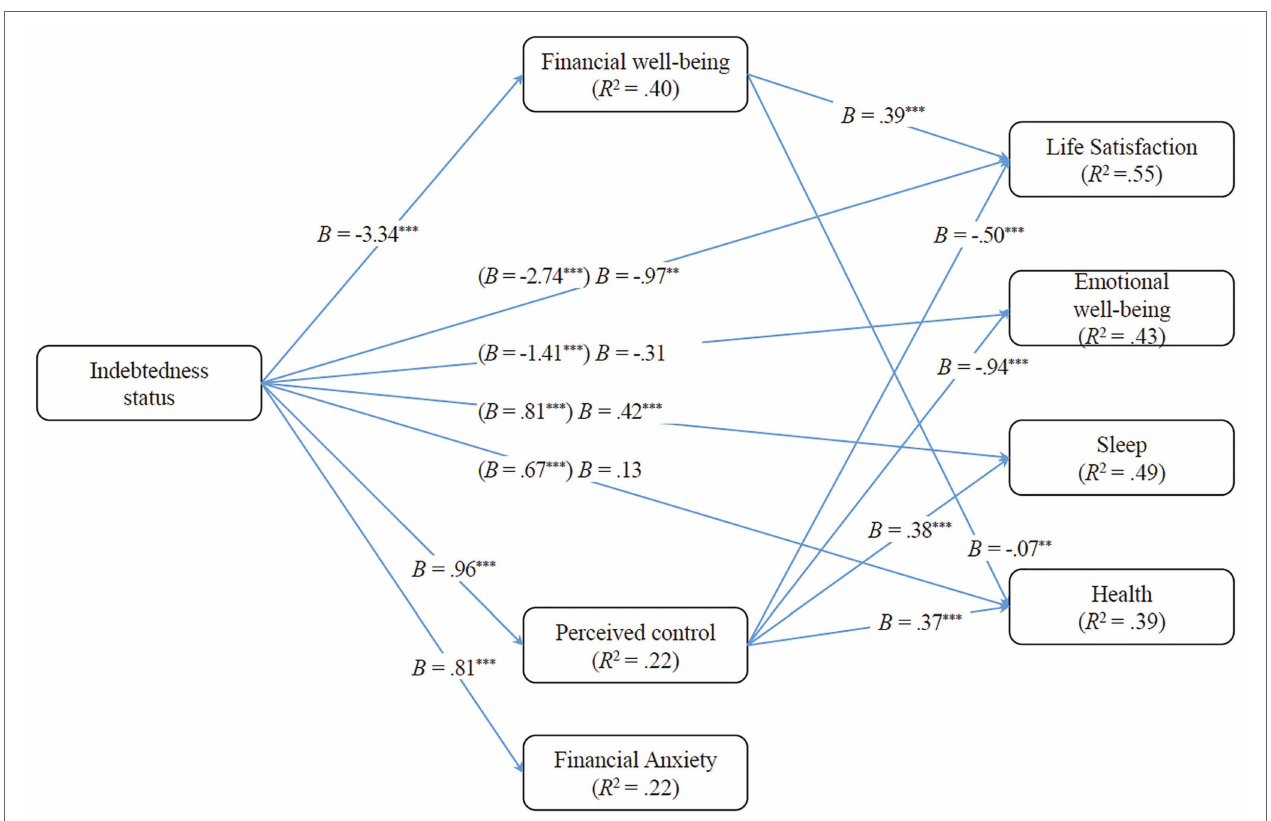
FIGURE 4 | Mediation model for the effect of indebtedness status on life satisfaction, emotional well-being, sleep, and health via perceived control, financial well-being, and financial anxiety.